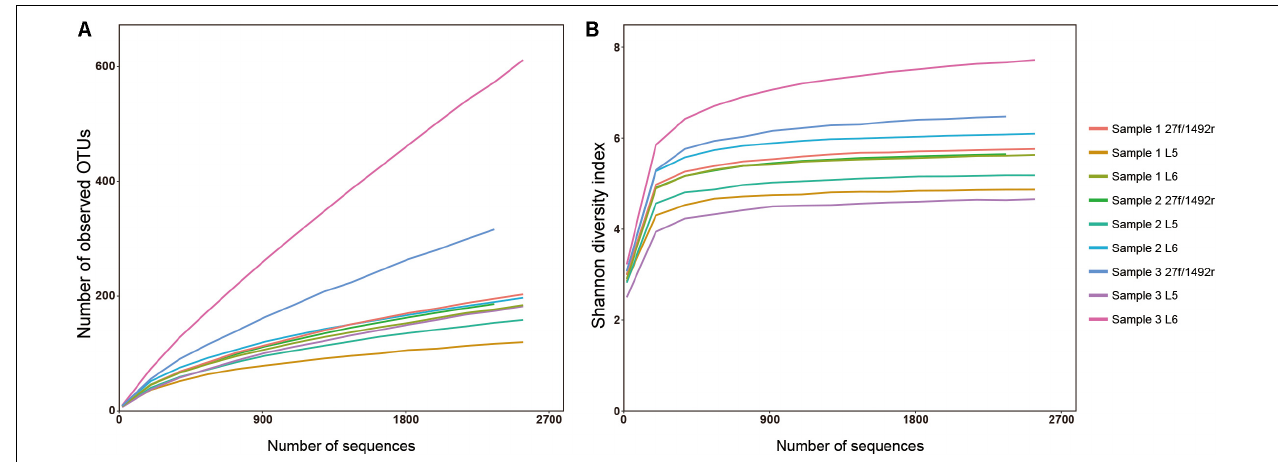
FIGURE 2 | (A) Rarefaction and (B) Shannon diversity of DNA sequences from three fecal samples amplified using the universal bacterial primer 27f and candidate LAB-specific primers. Sample 1, Sample 2, and Sample 3, were amplified using the universal bacteria primer 27f and LAB-specific primers L5 and L6 and sequenced using SMRT